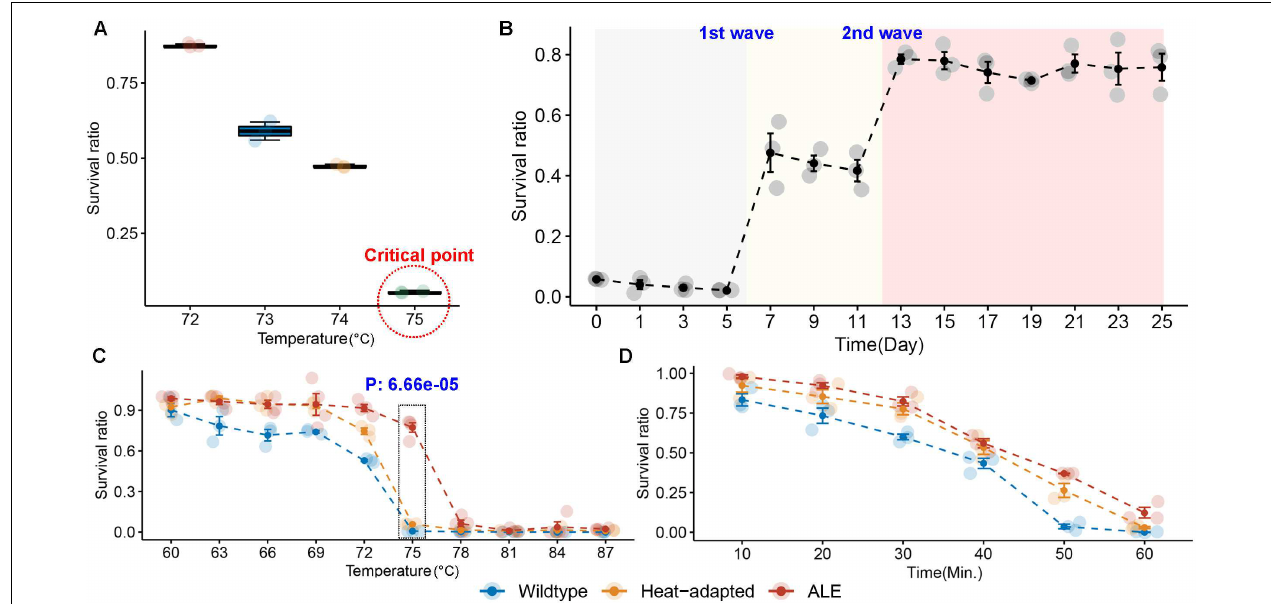
FIGURE 4 | Results of experiments to overcome the heat resistance limits of BIOPOP-3 strain. (A) Identification of heat resistance limit of heat-adapted BIOPOP-3 strain. (B) Change in survival rate of BIOPOP-3 in an ALE experiment for 25 days. (C) Comparison of survival rates of BIOPOP-3 WT, heat-adapted, and ALE strains at different temperature conditions. The heat exposure was fixed at 1 min. P -value from two groups t -test between ALE and others at 75 ◦ C. (D) Comparison of survival rates of three strains at different heat exposure time. The temperature was fixed at 60 ◦